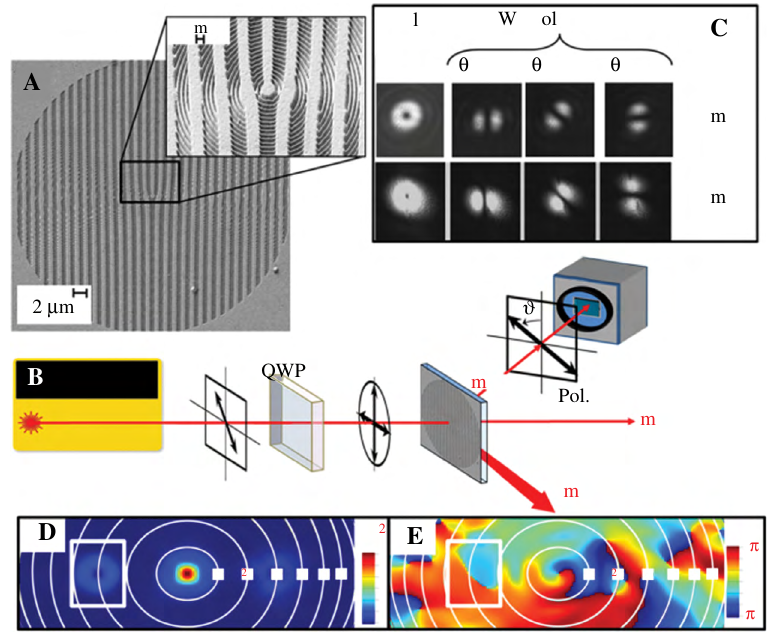
Figure 6 (A) SEM image of the fabricated hologram. (B) Experimental setup. (C) Measured far-field intensity distributions at two wave- lengths, with and without the linear polarizer. The transmission axis of the polarizer is indicated by the arrows. Simulated far-field (D) intensity and (E) phase profiles plotted in polar coordinates. Adapted from Ref.